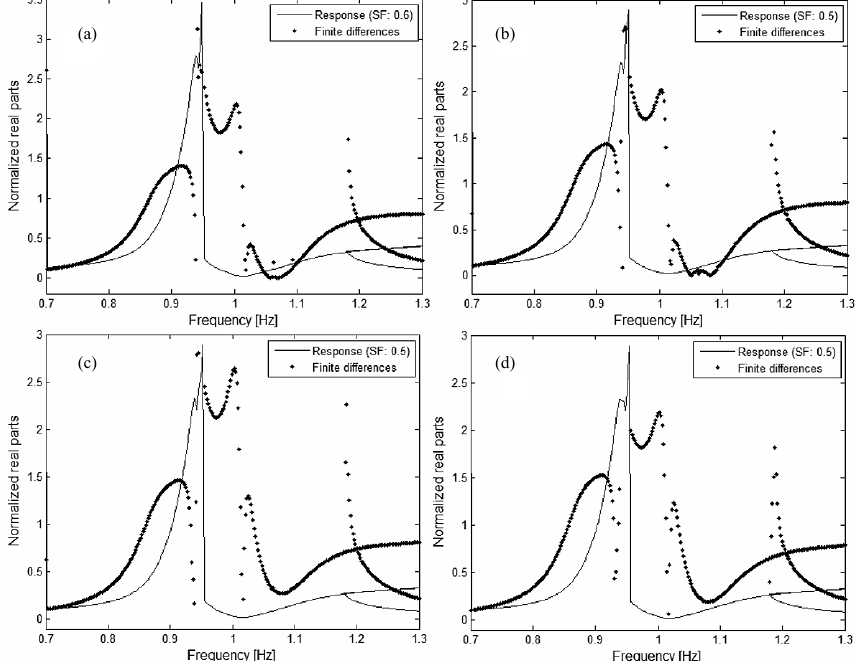
Fig. 6. Finite difference estimations of the Response H ( ω,p ) with respect to µ : (a) ∆ µ / µ = 1%; (b) ∆ µ / µ = 5%; (c) ∆ µ / µ = 10%; (d) ∆ µ / µ = 20%.